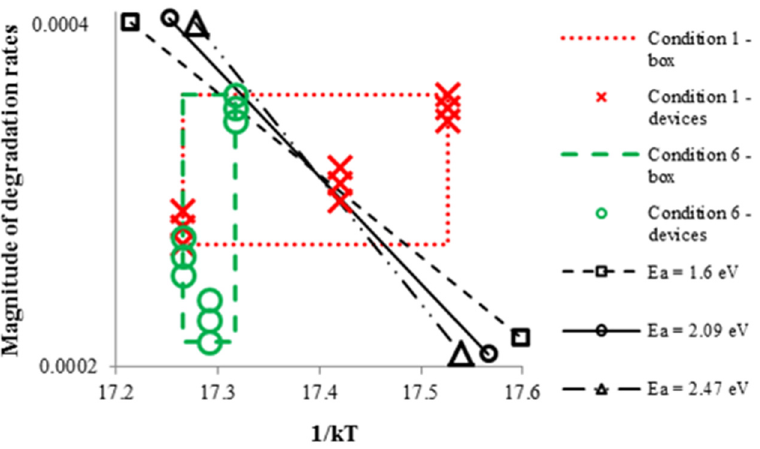
Figure 7. Comparison of Agilent power supply measurement error and initial T ch estimates in Conditions 1 and 6.